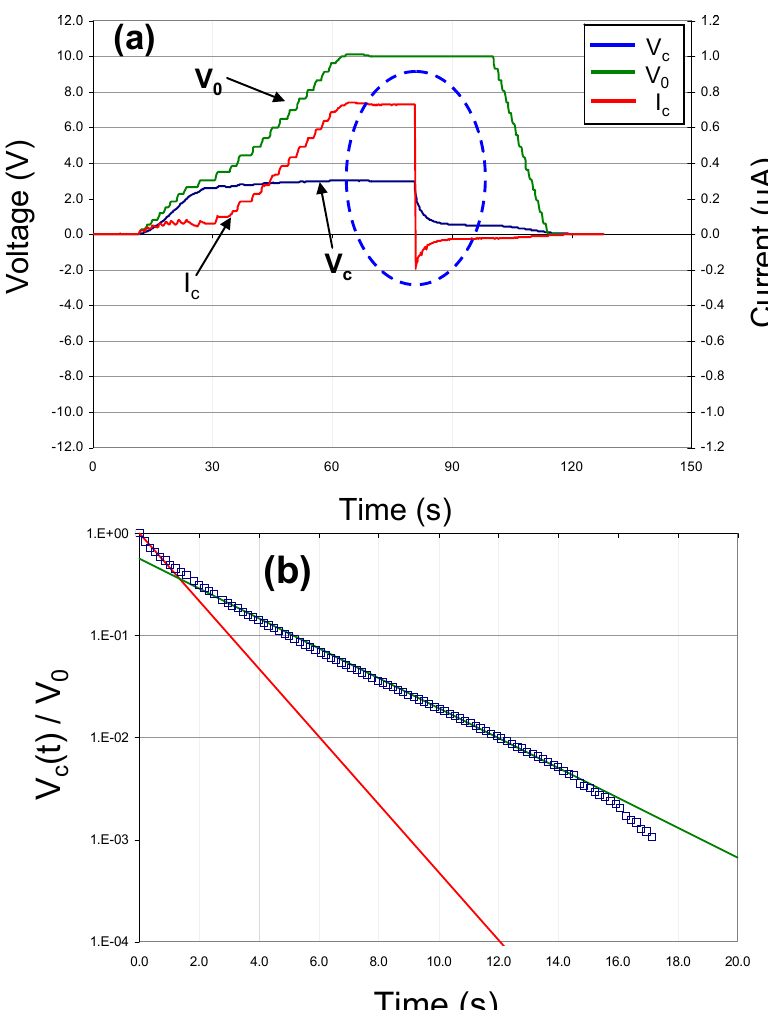
Figure 6. ( a ) DC charge/discharge data and ( b ) voltage decay behavior for capacitor with a Pt bottom electrode, a BCZTO dielectric deposited at 900 °C, 10 mtorr pressure, a sputter gas mixture of 10% oxygen/ 90% argon, and a Ni top